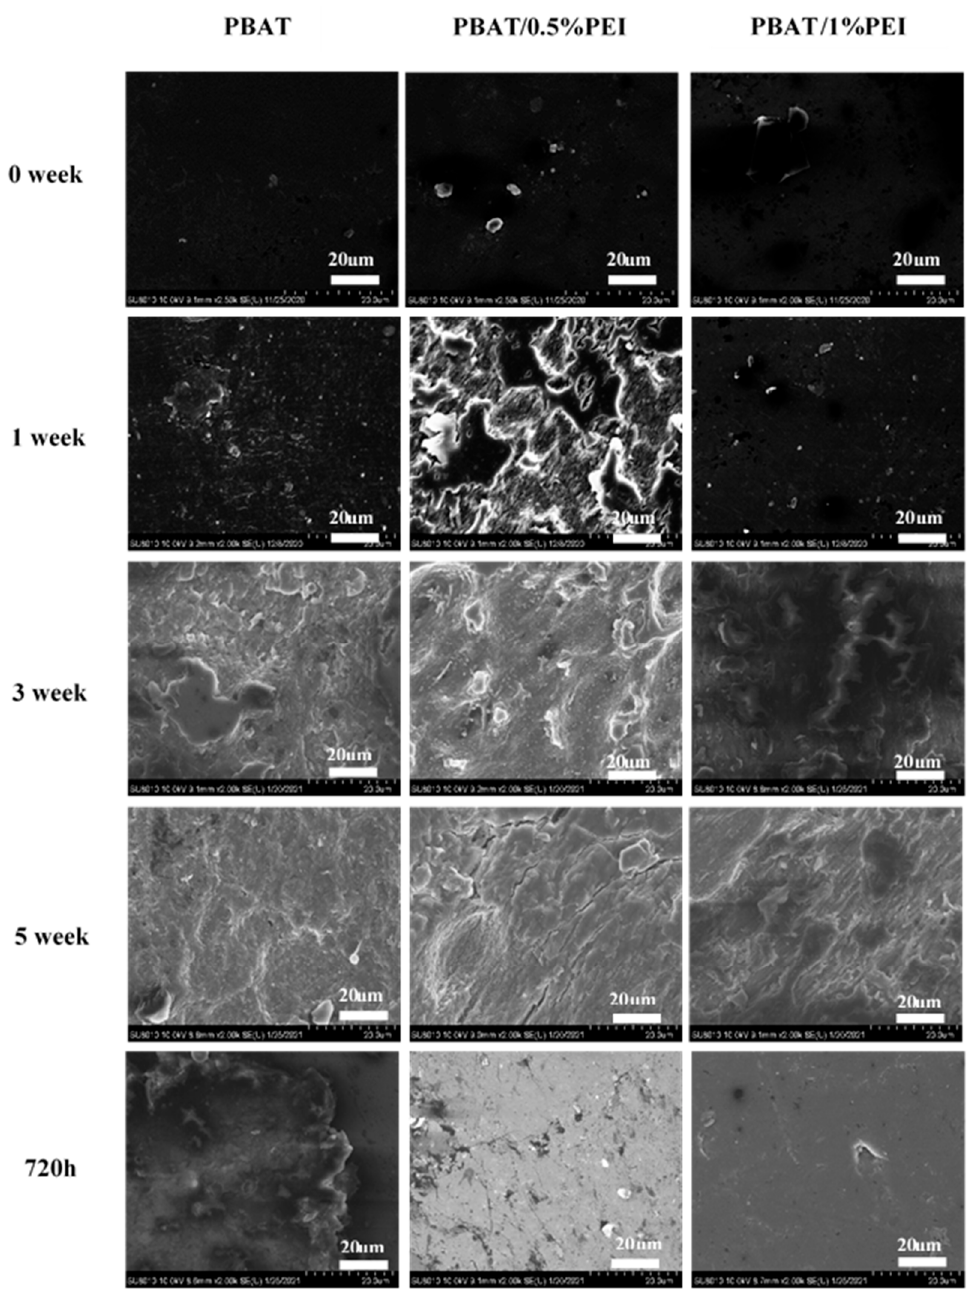
Figure 6. Micro morphology of films before and after degradation.